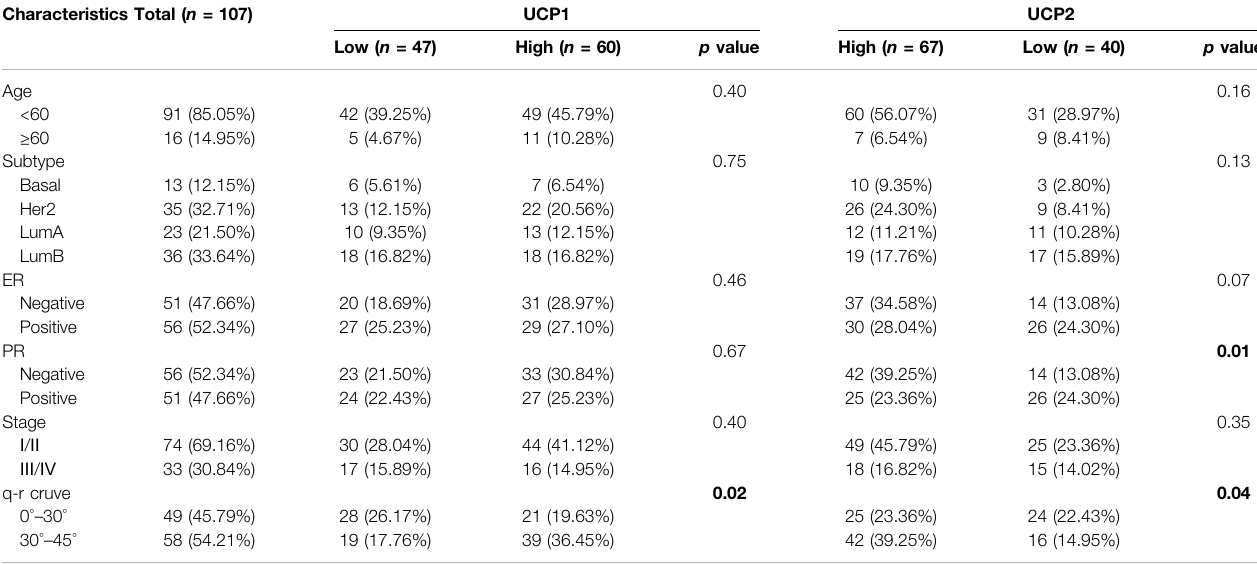
TABLE 1 | Clinical information of patients in cohort 2. Bold indicates p -values less than